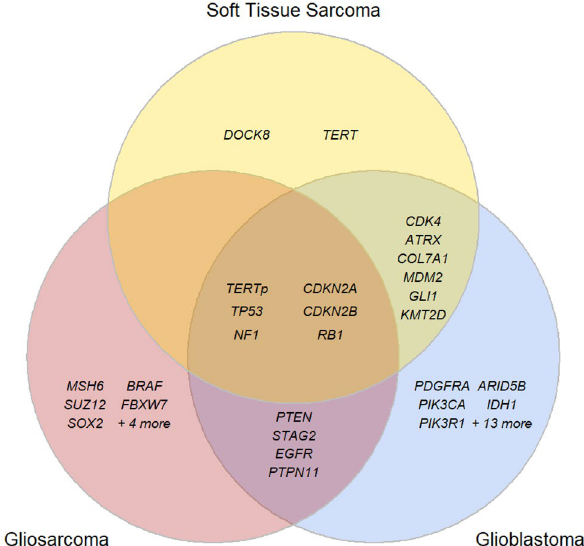
Figure 2. Genetic alteration comparison. Venn diagram of representative commonly altered genes in gliosarcoma, glioblastoma (GBM), and soft tissue sarcoma.